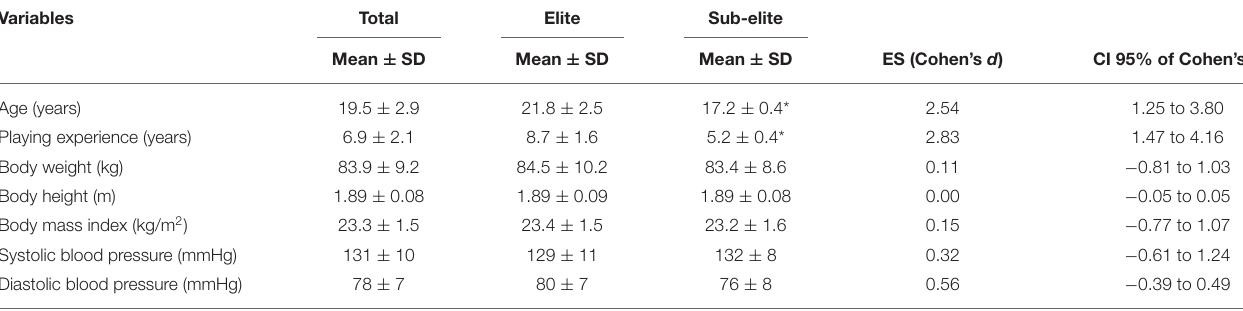
TABLE 1 | Descriptive characteristics of the elite ( N = 9) and sub-elite ( N = 9) basketball players. Variables